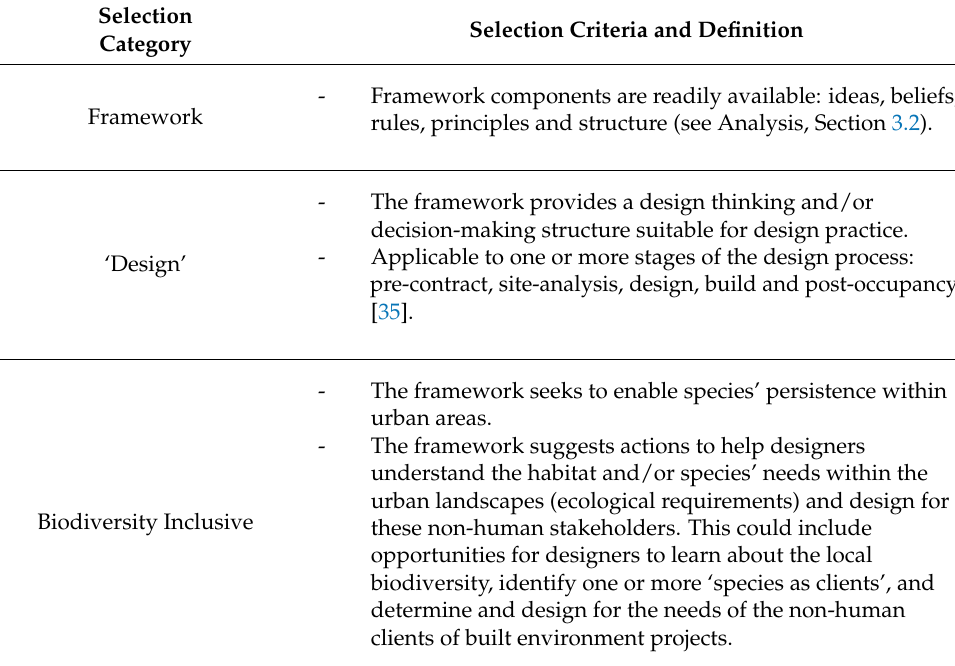
Table 1. Selection Criteria to find relevant Frameworks for